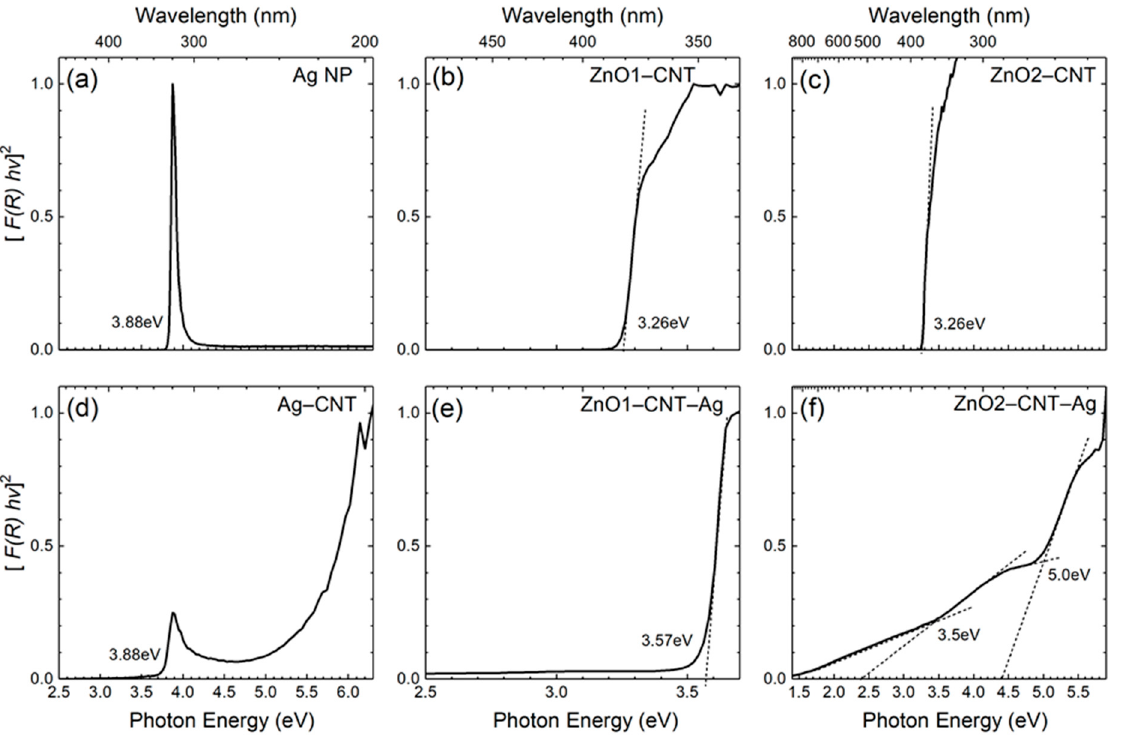
Figure 4. Tauc plots of the ( a ) free-standing Ag NP, ( b ) ZnO1–CNT, ( c ) ZnO2–CNT, ( d ) Ag–CNT, ( e ) ZnO1–CNT–Ag and ( f ) ZnO2–CNT–Ag nanohybrids.